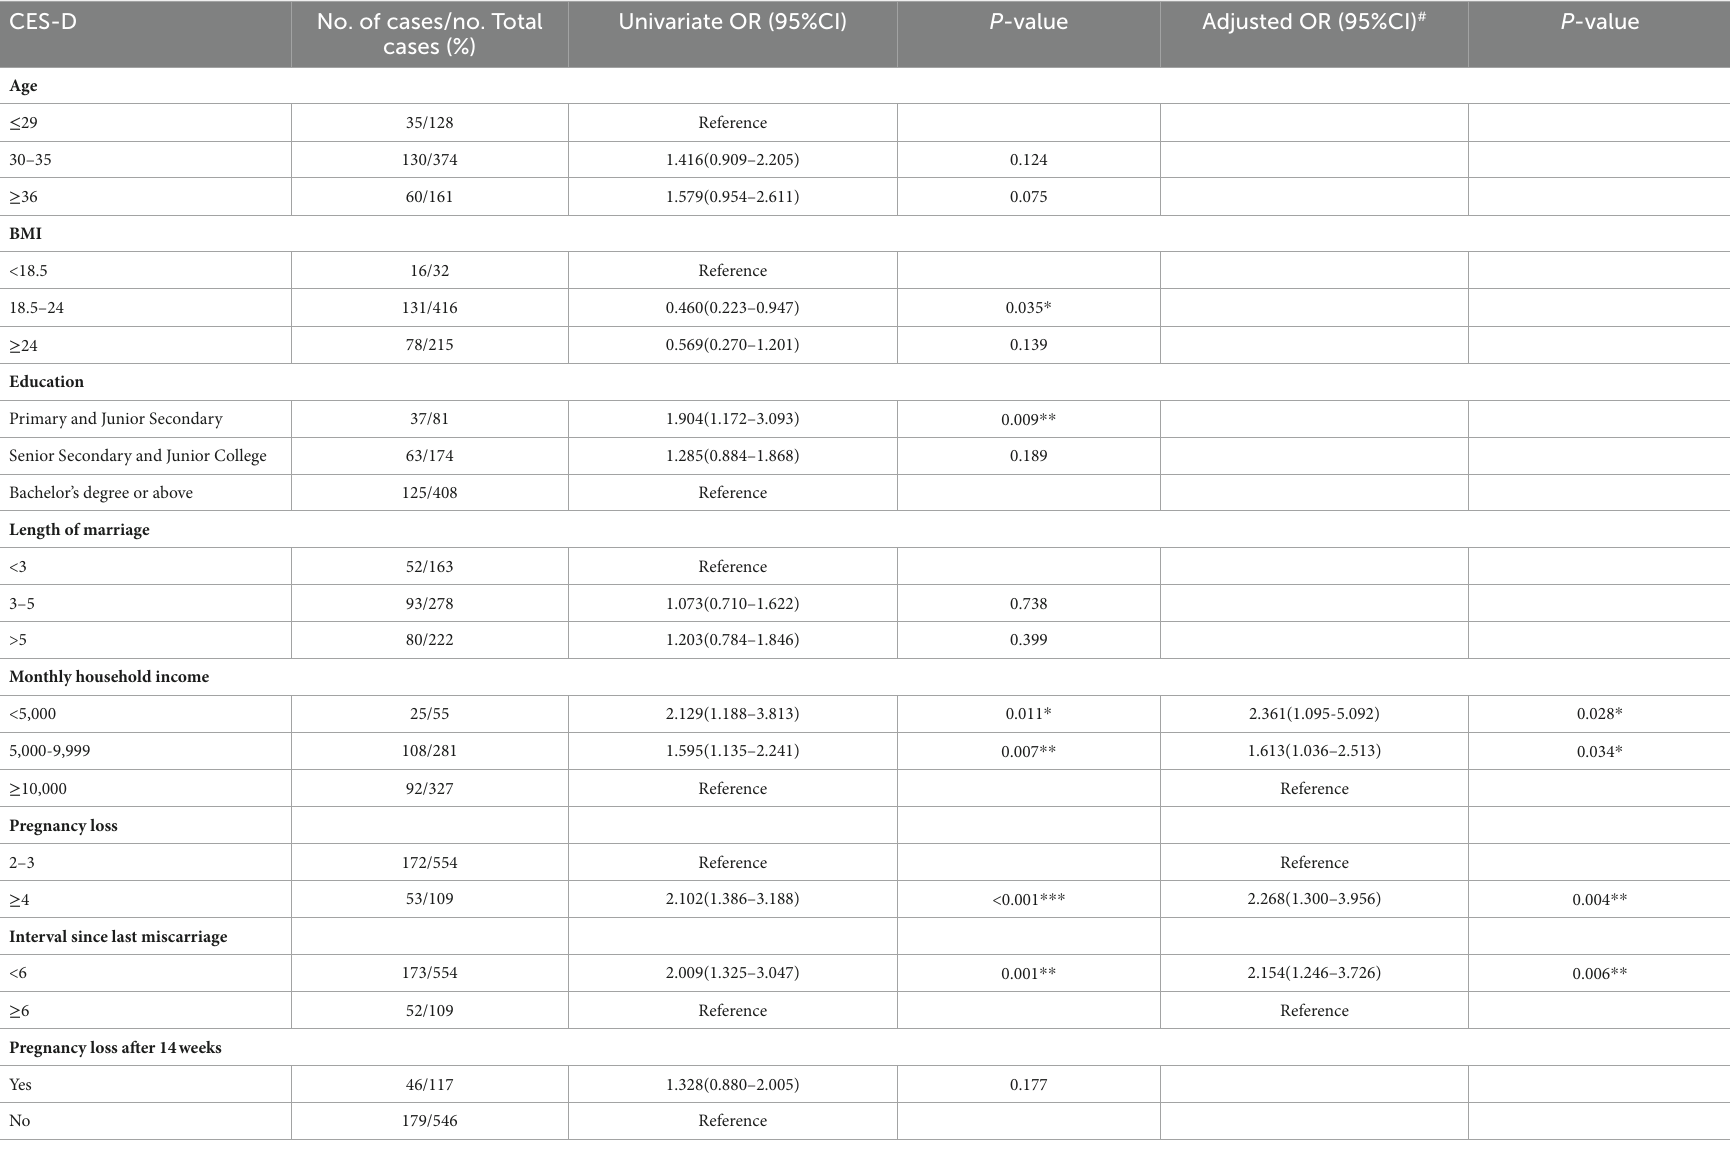
TABLE 8 Risk factors for depression (CES-D scores) identified by multivariable logistic regression analysis ( n = 663).